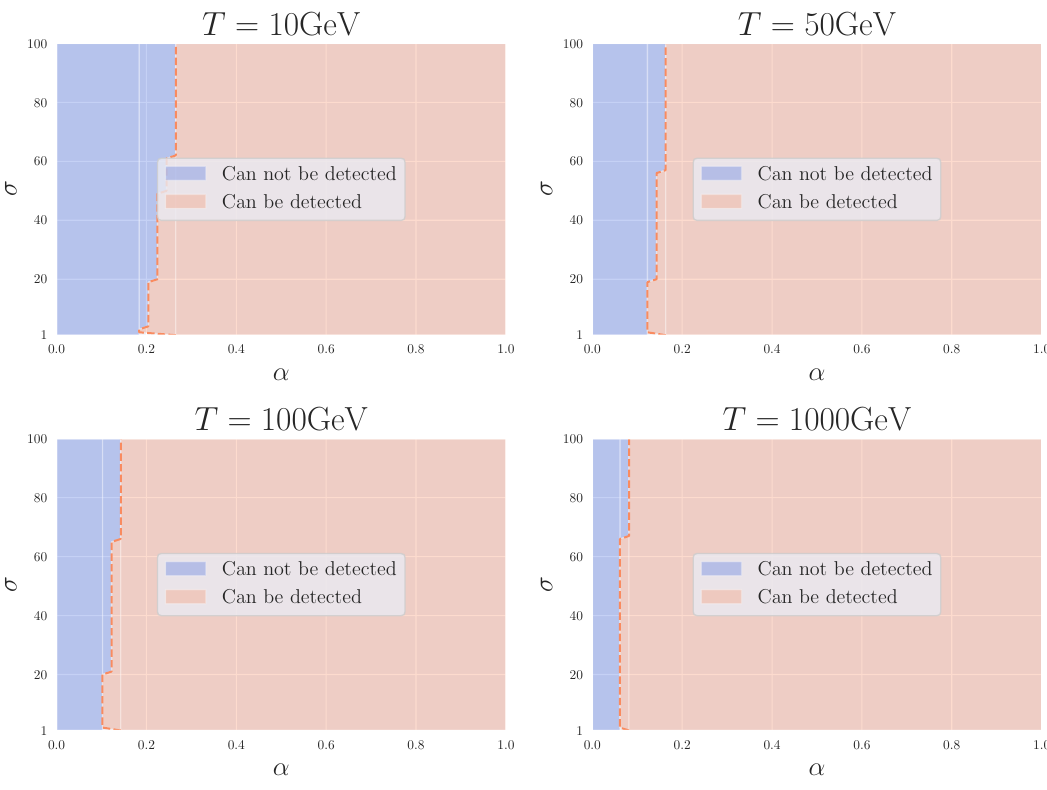
Figure 7 . Plotting of the parameter combinations in σ − α plane with different values of T ? . The upper left Lyons blue area denotes the pairs of ( σ, α, T ? ) whose corresponding GW can not be detected, while the lower right salmon pink area denotes the pairs of ( σ, α, T ? ) whose corresponding GW can be